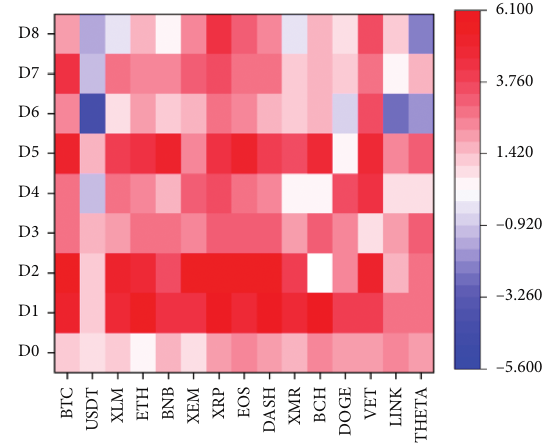
Figure 16: LTC to the other. Figure 13: ETH to the